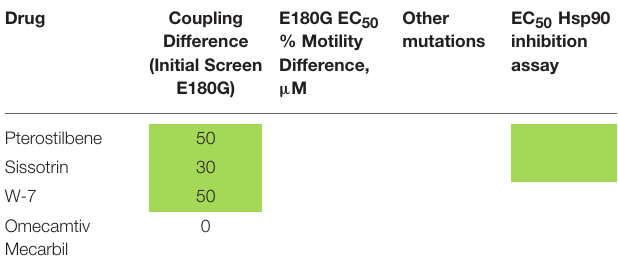
TABLE 1 | Ability of small molecules to re-couple troponin in thin myofilaments measured by in vitro motility assay.